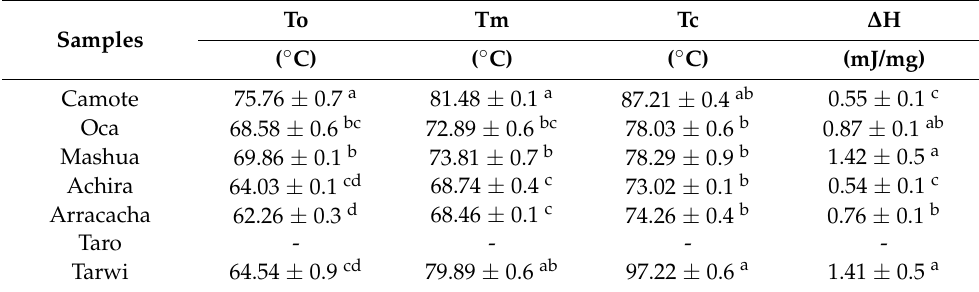
Table 5. Differential scanning calorimetry (DSC) results for andean crops flours.